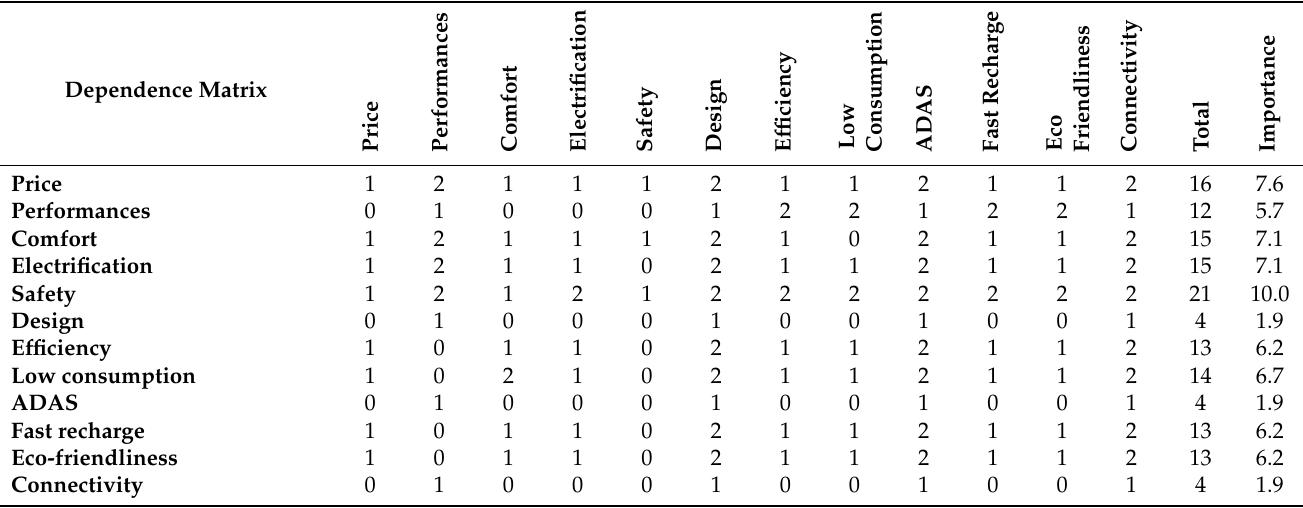
Table 5. Importance